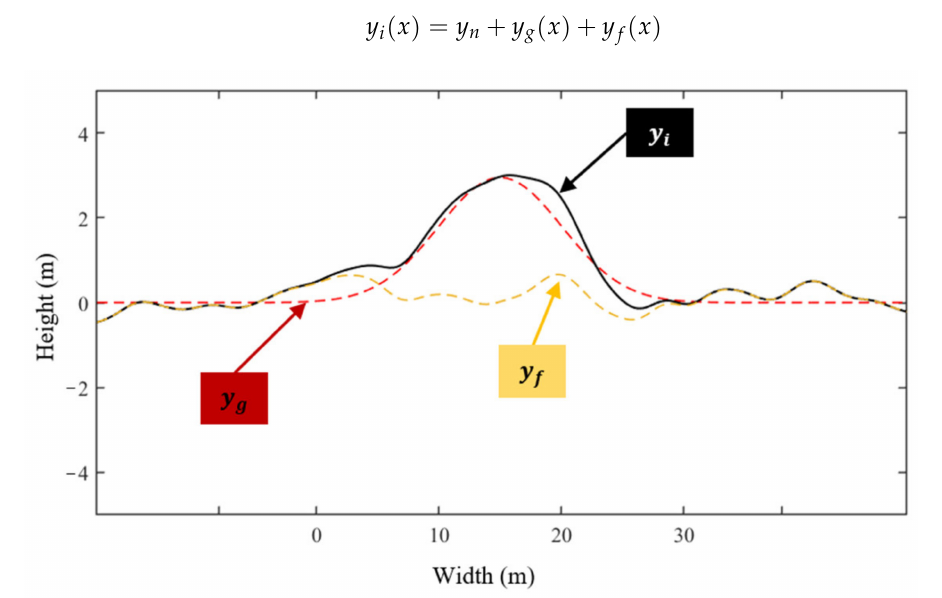
Figure A5. Interface with